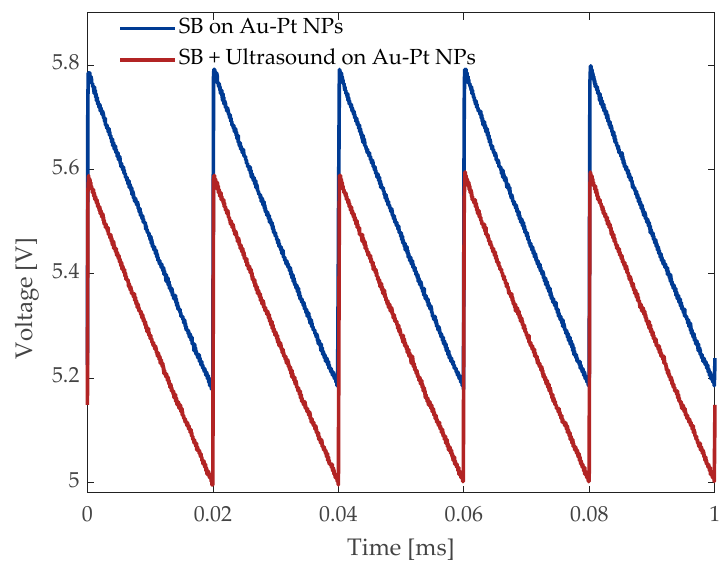
Figure 9. Amplitude vs time spectrum of single-beam transmittance measured at the output light with a pulse energy of 5.5 μ J.